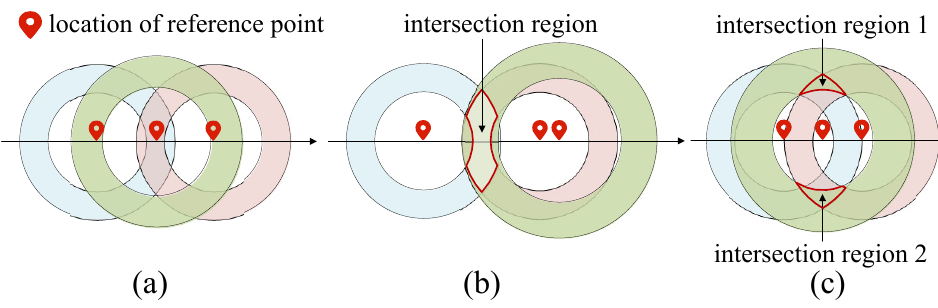
Figure 7. Collinear situation of reference points. ( a ) Case 1. ( b ) Case 2. ( c ) Case